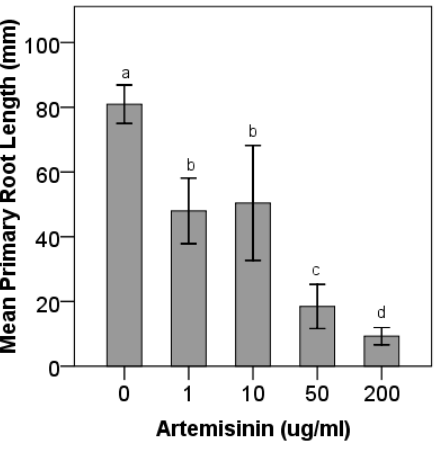
Figure 7. Root growth of A. annua seedlings grown in different concentrations of artemisinin. Letters indicate statistical differences at p ≤ 0.05( via ANOVA/Tukey